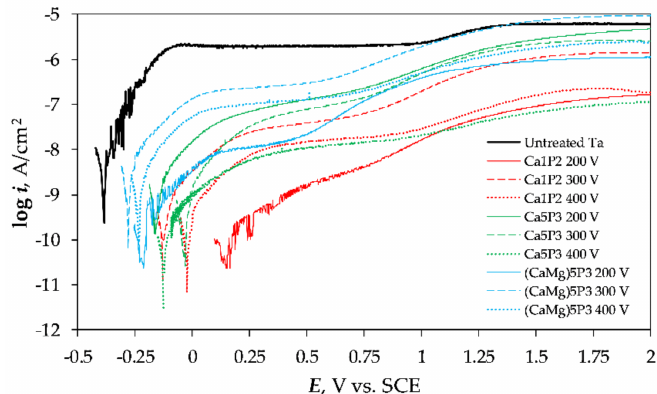
Figure 8. Potentiodynamic polarization curves measured in Ringer physiological solution for the Ta samples before (Untreated Ta) and after the